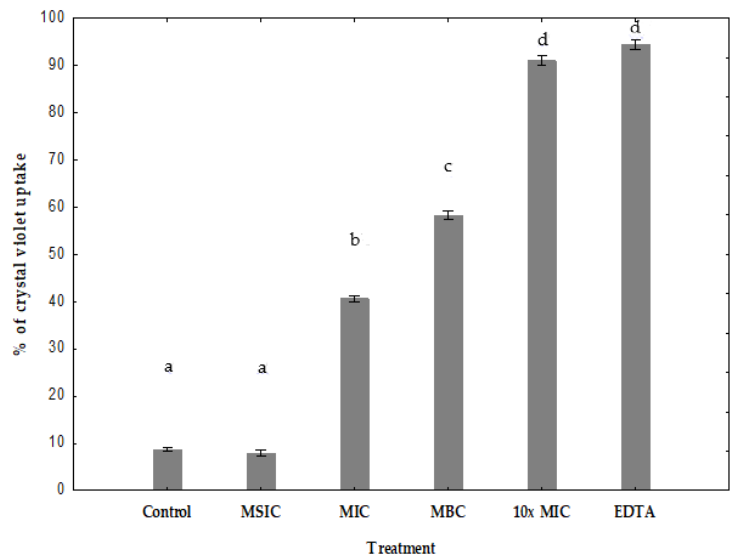
Figure 5. Change in bacterial membrane permeability of EHEC A (assayed by crystal violet uptake) in presence of different concentrations of hibiscus acid and EDTA. Percentage of crystal violet uptake was plotted against the concentration of the treatment. The mean ± standard deviation for three replicates are illustrated. Values with different letters express significant difference at α = 0.05 by Tukey’s test. MSIC: minimum sub-inhibitory concentration, MIC: minimum inhibitory concentration, MBC: minimum bactericidal concentration, 10 × MIC: 10 × minimum inhibitory concentration, EDTA: ethylenediaminetetraacetic acid.